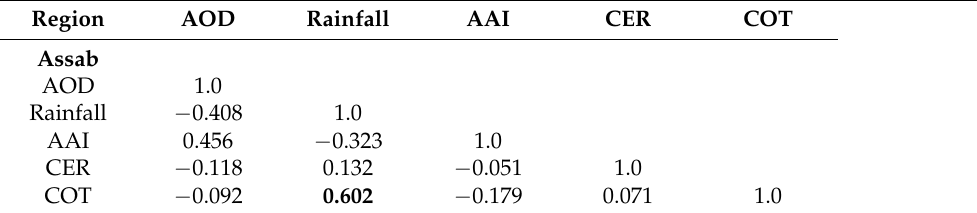
Table 5. The correlation coefficient values between AOD, rainfall, AAI, CER, and COT over Assab in July 2001 to 2018. The correlation coefficient (R) values of ≥ 0.468 (critical R-value) are highlighted in bold.